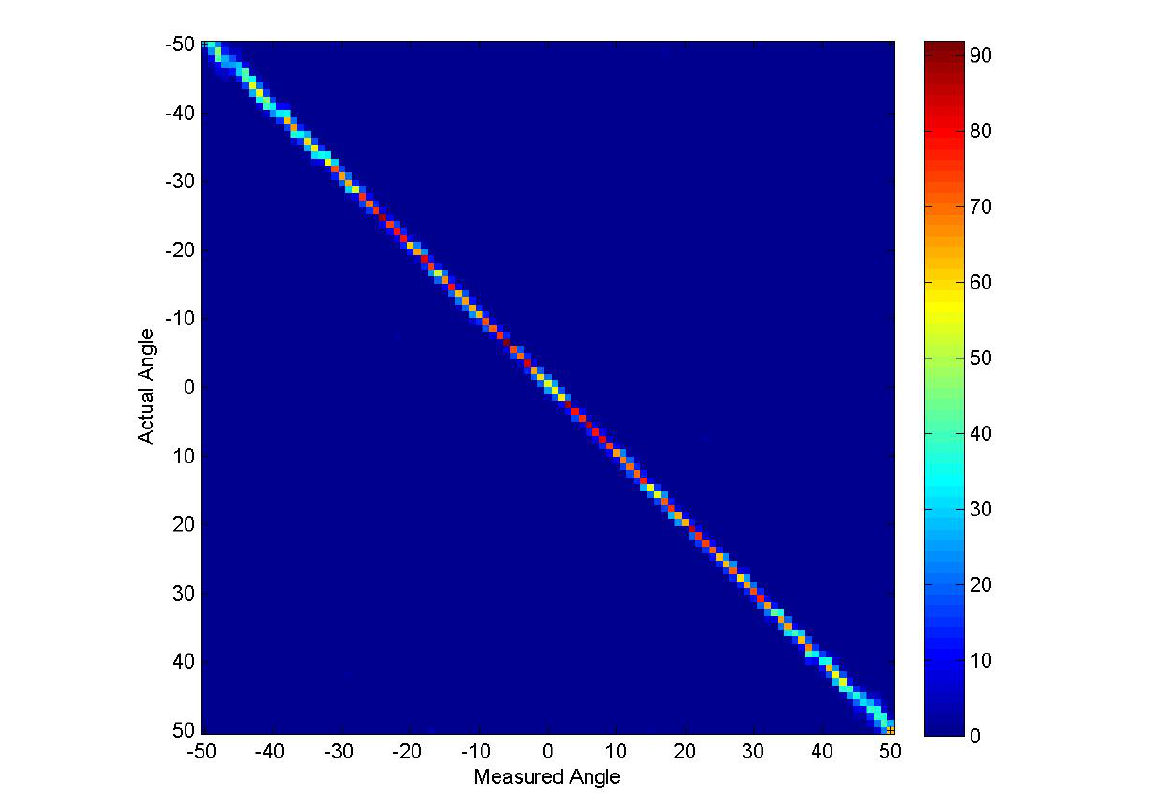
Figure 15. Ambiguity plot for experiment 5 (no